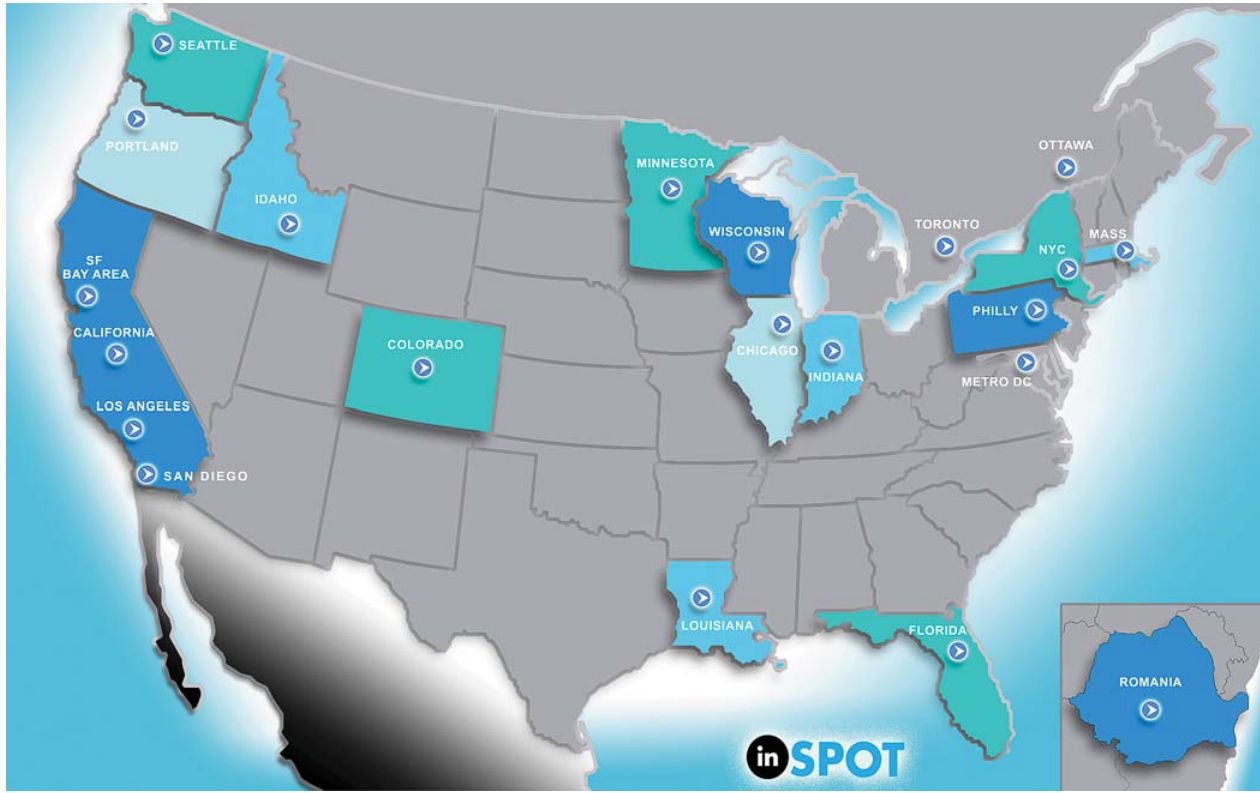
Figure 3. Currently Participating Jurisdictions